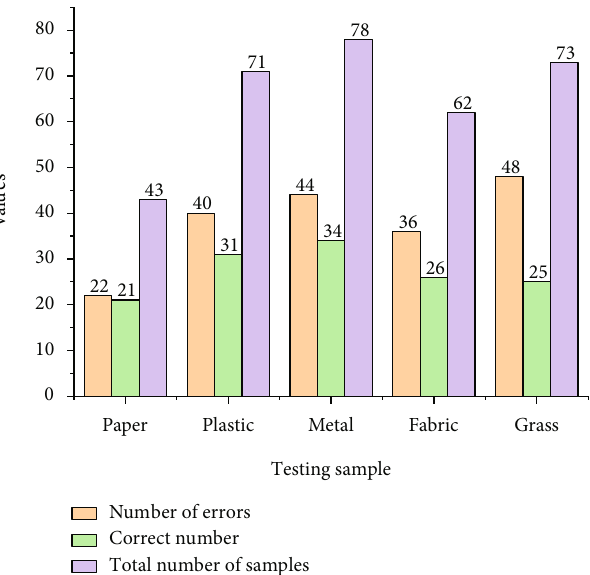
Figure 6: Model loss results with di ff erent learning rates.